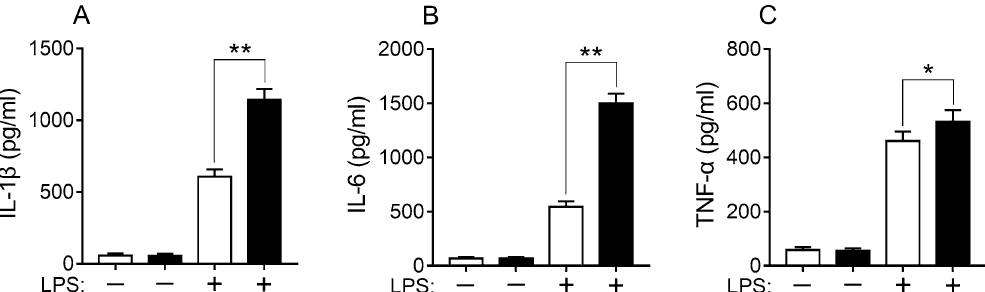
Figure 1. Different responses of RAW264.7 and RAW264.7-IRG1KO to LPS stimulation. ELISA kit test results of cytokines IL-1β ( A ), IL-6 ( B ) and TNF-α ( C ) in RAW264.7 and RAW264.7-IRG1KO cell culture medium when exposed to LPS (24 h). ITA, itaconic acid; LPS, lipopolysaccharide. White bar, RAW264.7; black bar, RAW264.7-IRG1KO. Values represent the mean ± S.E.M. *, p < 0.05; **, p <